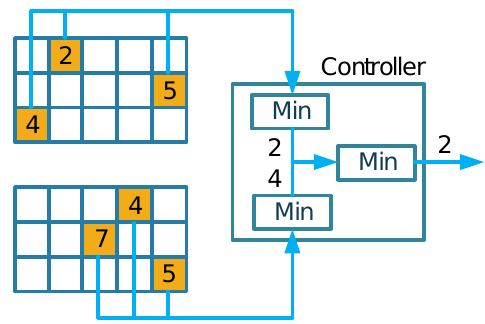
Figure 4. Merge two Count–Min